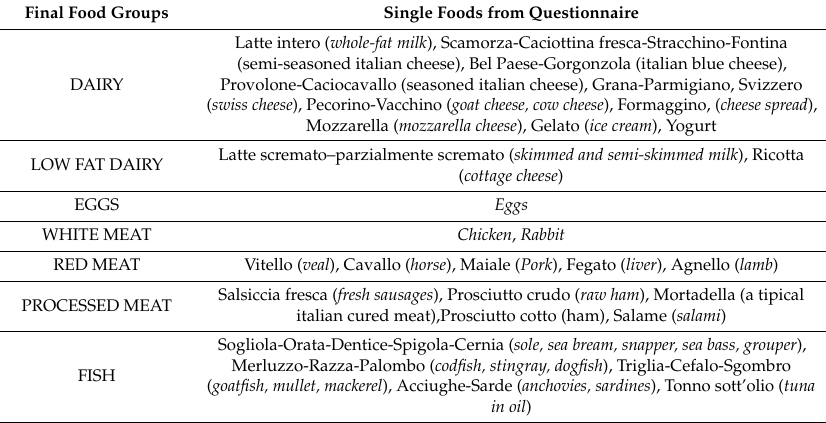
Table A1. Concordance of the single food in the questionnaire and the food grouping used in the